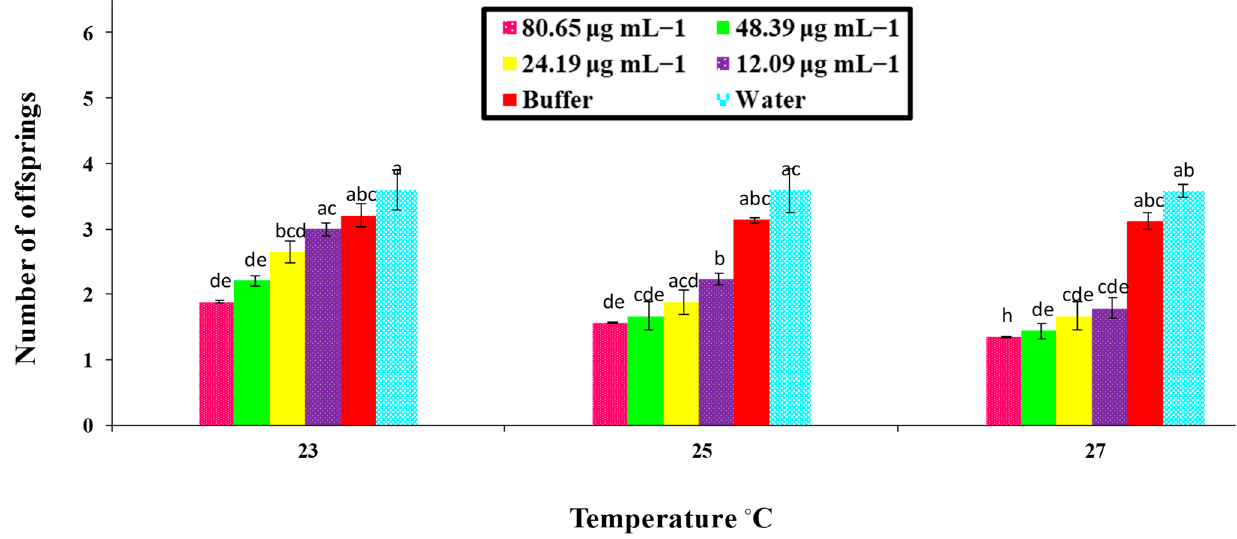
Figure 5. Average fecundity with (± SE) of aphids ( M. persicae ) on chili plants with various PeaT1 elicitor protein changed concentrations at different altered temperature regimes ( n = 10); alphabet letters on each bar’s top show inequalities between treatments (factorial analysis one-way ANOVA; LSD at α = 0.05). Fecundity was reduced in PeaT1-treated seedlings.